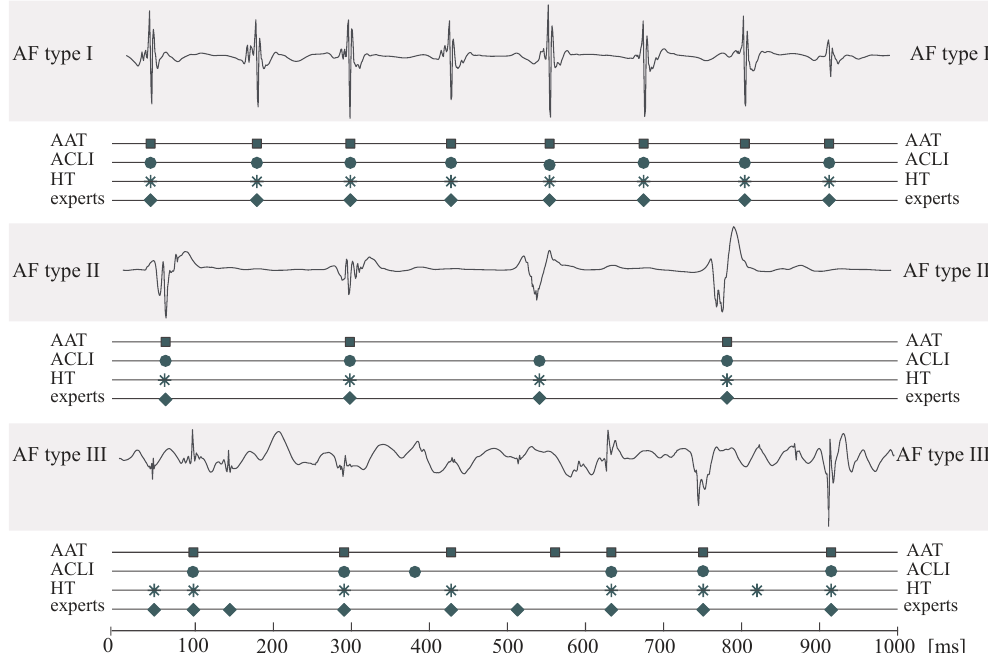
Figure 4. One-second example of the three EGM types and the annotations made from the three algorithms as well as from the experts. Experts’ annotations are considered as ground truth. For AF type I, activations were clearly distinguished from the baseline and all the methods were able to identify them. For AF type II, although the baseline shows little perturbation, lower amplitude activations slightly complicate the procedure, leading to a mishit for the AAT algorithm. Finally, for AF type III EGMs, mishits and false positives are observed for all methods across the